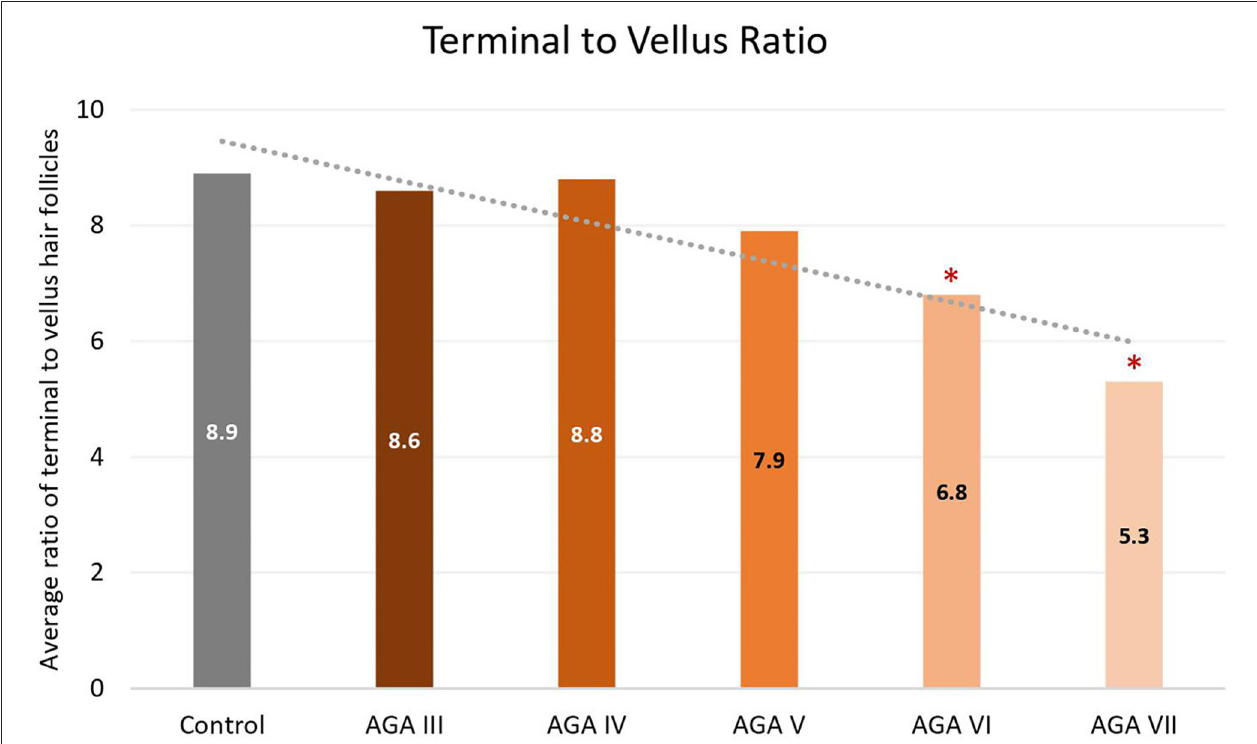
FIGURE 3 | Terminal to vellus hair ratio between controls and patient subgroups with different disease severity of androgenetic alopecia (AGA) . * P < 0.05 when compared to the control